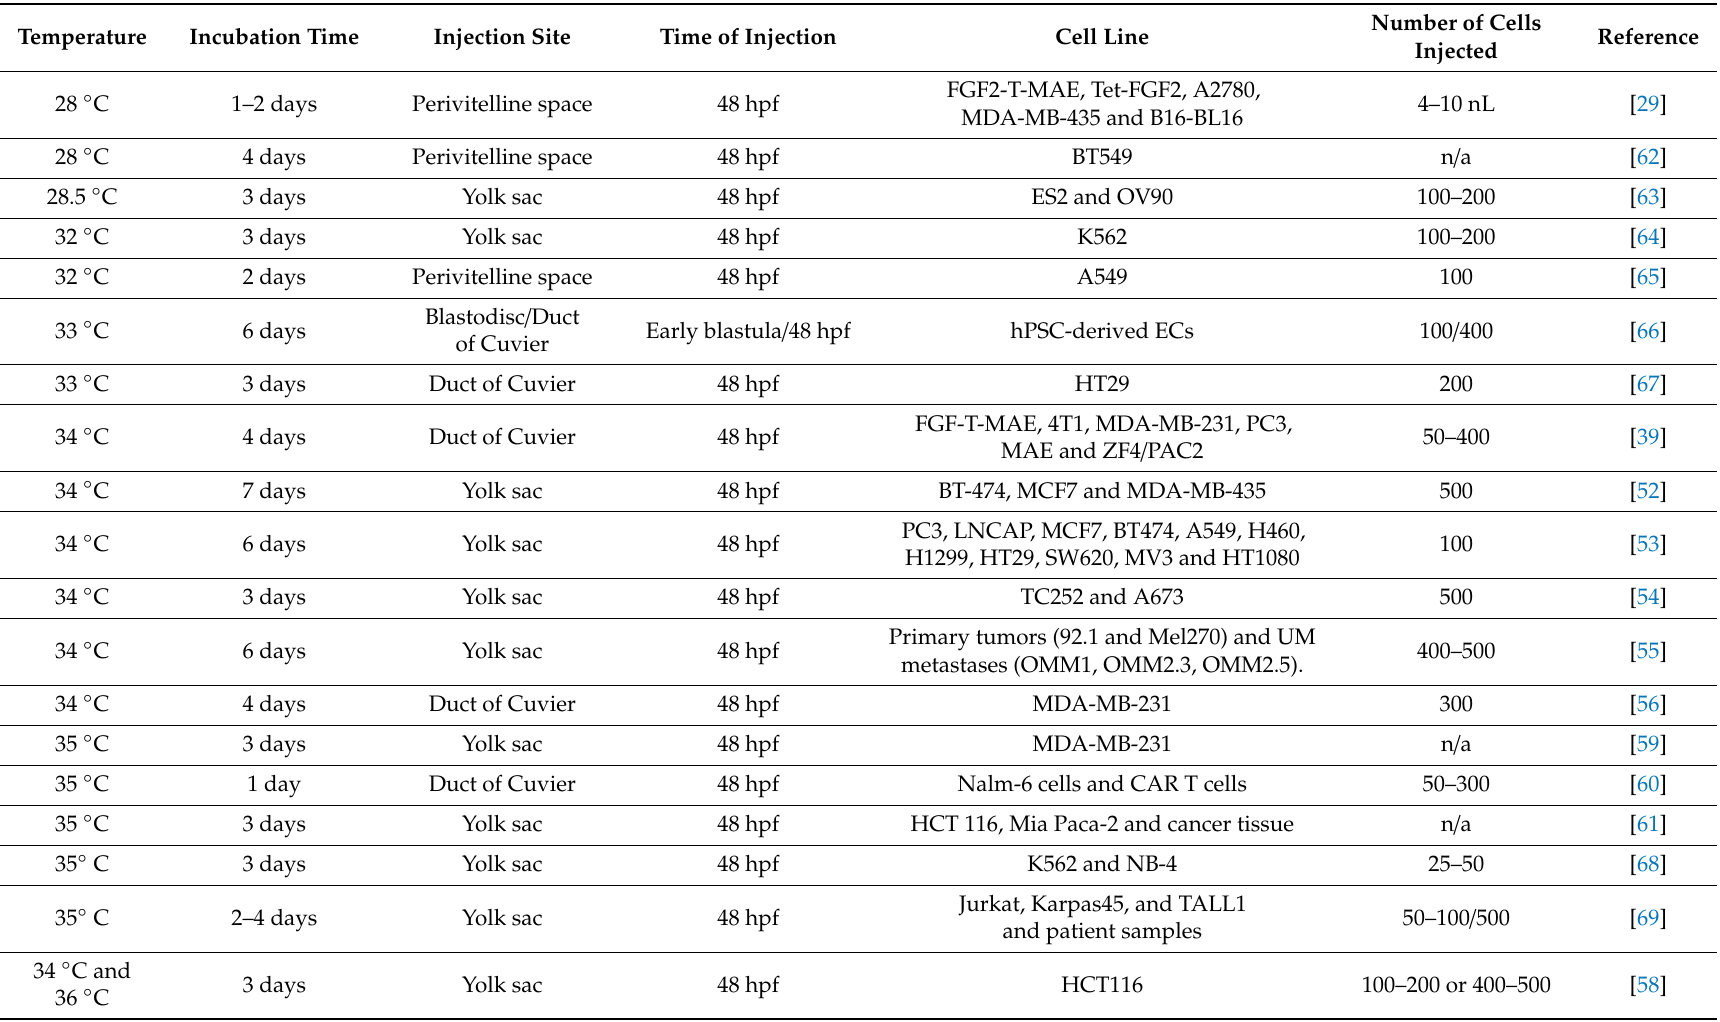
Table 1. Summary of incubation temperatures in xenograft